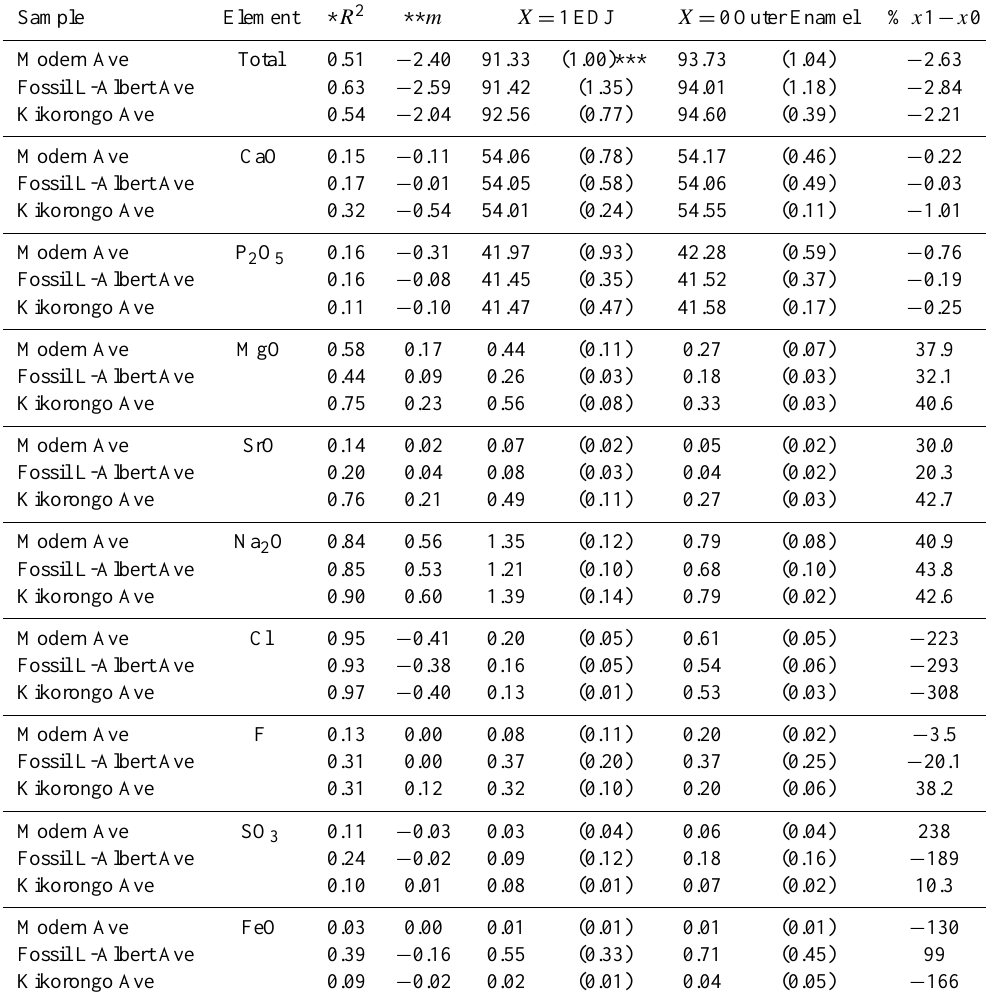
Table 4. Regression analysis of the element distribution in enamel along profiles from the outer enamel rim ( x = 0) towards the enamel-dentin junction ( x =